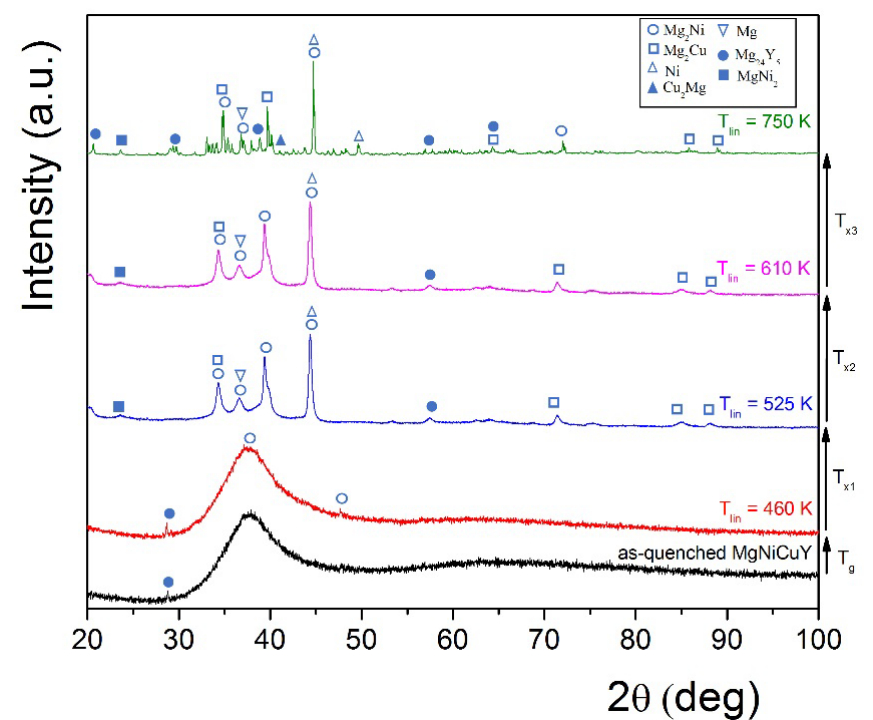
Figure 1. X-ray diffraction patterns for as-quenched Mg 65 Ni 20 Cu 5 Y 10 metallic glass and after contin- uous heating to the indicated temperatures.